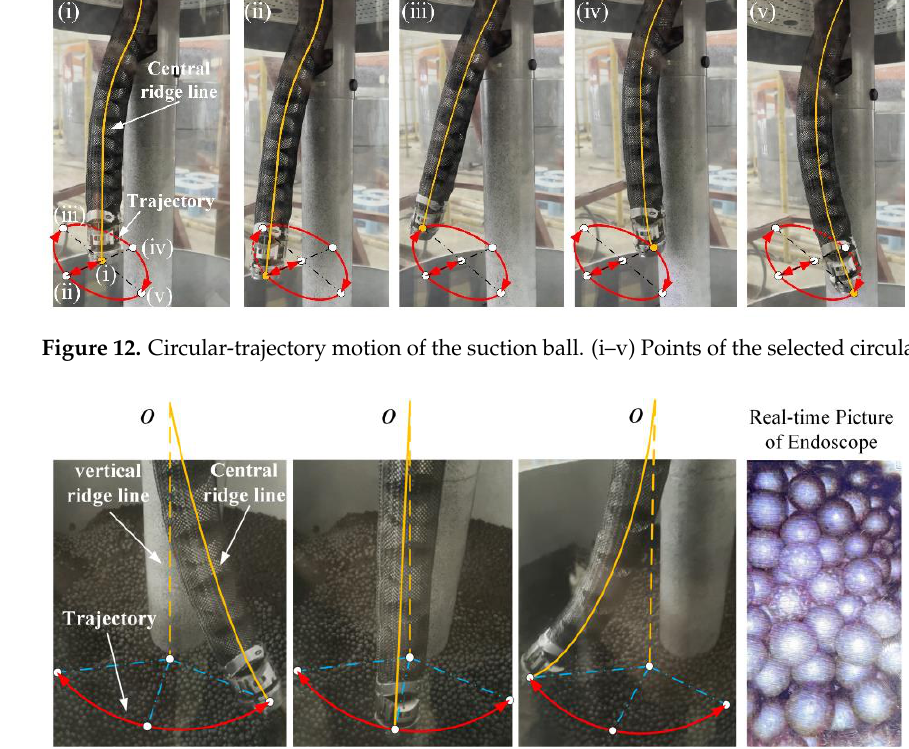
Figure 14. Test of the continuum robot around the column: ( a ) initial state; ( b ) 180° left around the column; ( c ) 180° right around the column. 5.2. Test for Function 3 In the engineering test environment, absorber ball-removal efficiency was tested with lift ≥ 6 m. It can be seen from Table 2 and Figure 15 that the efficiency of absorber ball removal is related to the lift, tube material, and diameter. The test results show that, within the test range, the tube diameter is directly proportional to the removal efficiency (Tests 1, 2, 3; 4, 5, 6; 7, 8, 9; 10, 11, 12; 13, 14, 15), while the lift is inversely proportional to the removal efficiency (Tests 10, 13; 11, 14; 12, 15). Among them, the ball- sucking tube of “PVC + steel wire” has the highest removal efficiency in each of their respective groups. How- ever, due to the high viscosity of the tube inner wall, when the suction fan stops running, the absorber ball still in the tube will be blocked in the falling process, affecting the sub- sequent removal operation. Furthermore, the removal efficiency of the PU tube is the low- est due to the limitation of tube diameter, with which it is easy to form a local vacuum environment in the pipeline. Moreover, the PU tube and “PU + steel wire” tube has strong toughness, which will hinder the passive flexible deformation of the robot arm at the di- vider plug. Table 2. Removal efficiency tests for absorber ball removal in a gas environment. Test